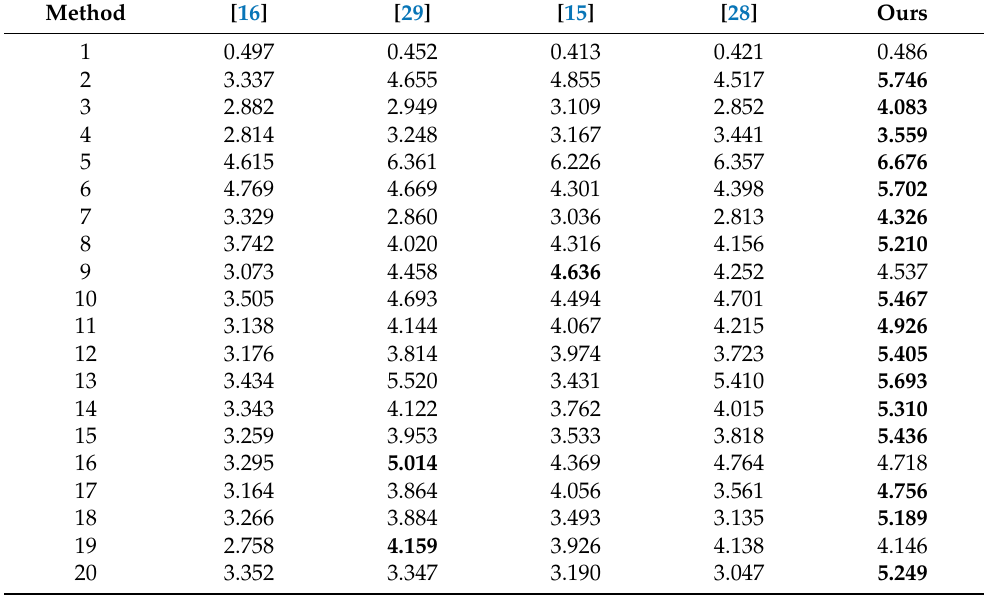
Table 1. Objective evaluation results of